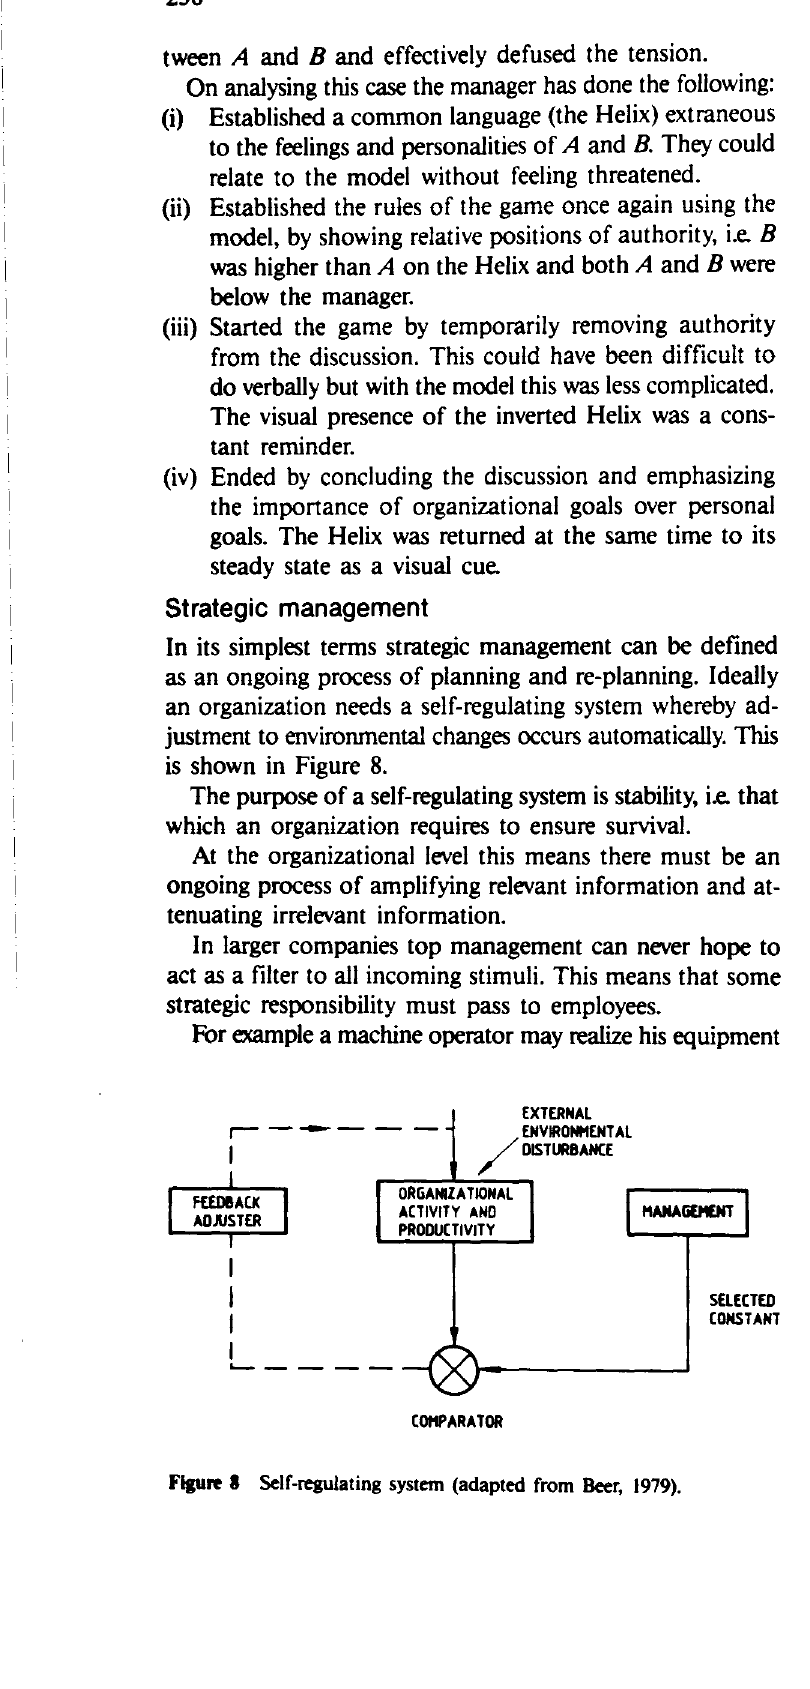
Figure 8 Self-regulating system (adapted from Beer,